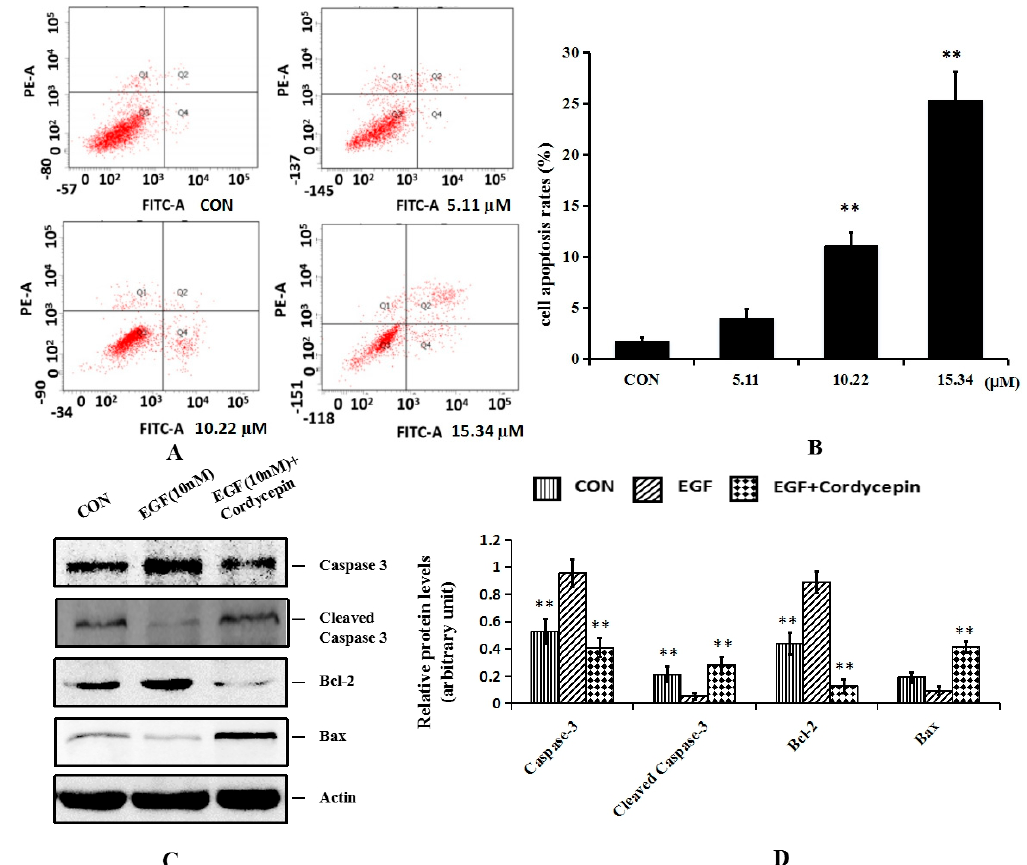
Figure 4. Effects of cordycepin on the apoptosis of H1975 cells and related protein caspase-3 and Bcl-2 in vitro. ( A ) H1975 cells were treated with cordycepin at 5.11 µM, 10.22 µM and 15.34 µM for 48 h and cell apoptosis was analyzed by flow cytometry; ( B ) Histogram summarized the results of ( A ). The activity of H1975 was evaluated by Annexin-V/PI staining; ( C ) Western blot showed the protein level of caspase-3, cleaved caspase-3, Bax and Bcl-2 following the cordycepin (10.22 µM) treatment for 24 h. Actin served as an equal loading control; ( D ) Histogram summarized the results of ( C ). Error bars represent means ± SEM of n = 3. ** p < 0.01 vs. control group.